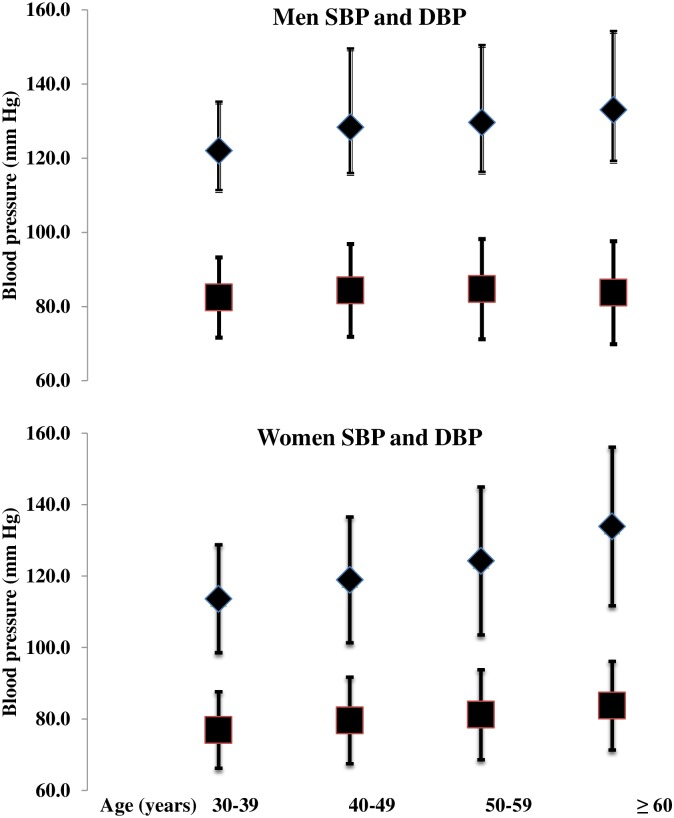
Mean SBP and DBP stratified by age and sex bars represent the standard deviation (SD), Abbreviations: SBP; systolic blood pressure and DBP; diastolic blood pressure.